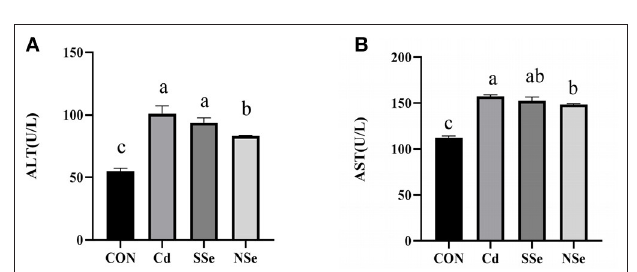
FIGURE 2 | Activities of ALT and AST in serum. (A) Serum ALT level; (B) Serum AST level. Different letters represent significant difference ( P < 0.05) within the column, and the same letters represent no significant difference ( P > 0.05).